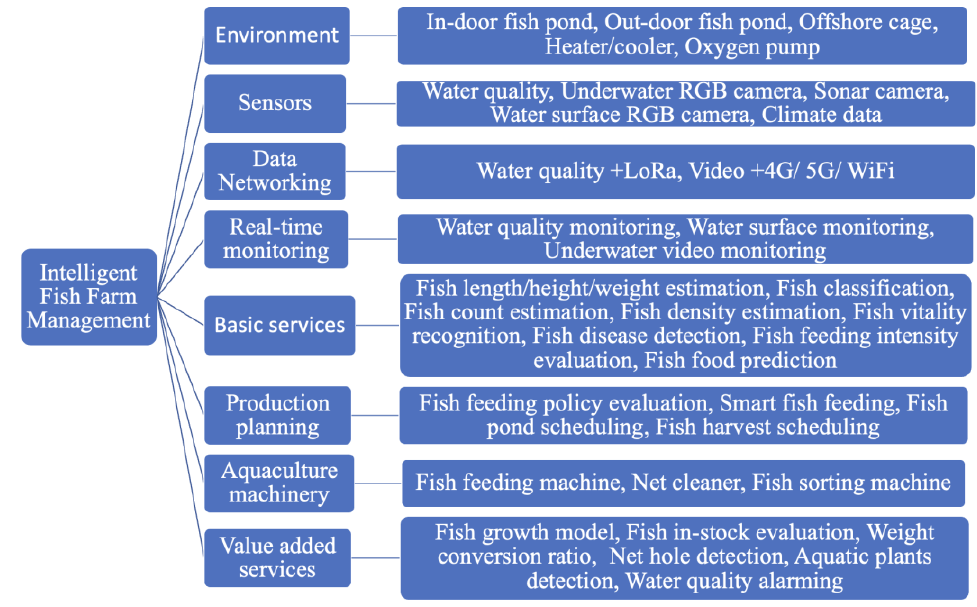
Figure 4. User requirement analysis of intelligent fish farming using digital twins [9].